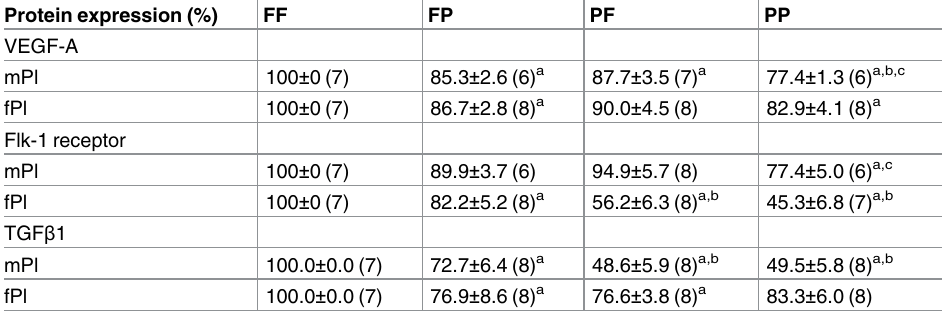
Table 6. Protein expressionof VEGF-A, Flk-1 and TGF β 1 in the maternal and fetal portions of the placenta. Protein expression (%) FF FP PF PP VEGF-A mPl 100 ± 0 (7)